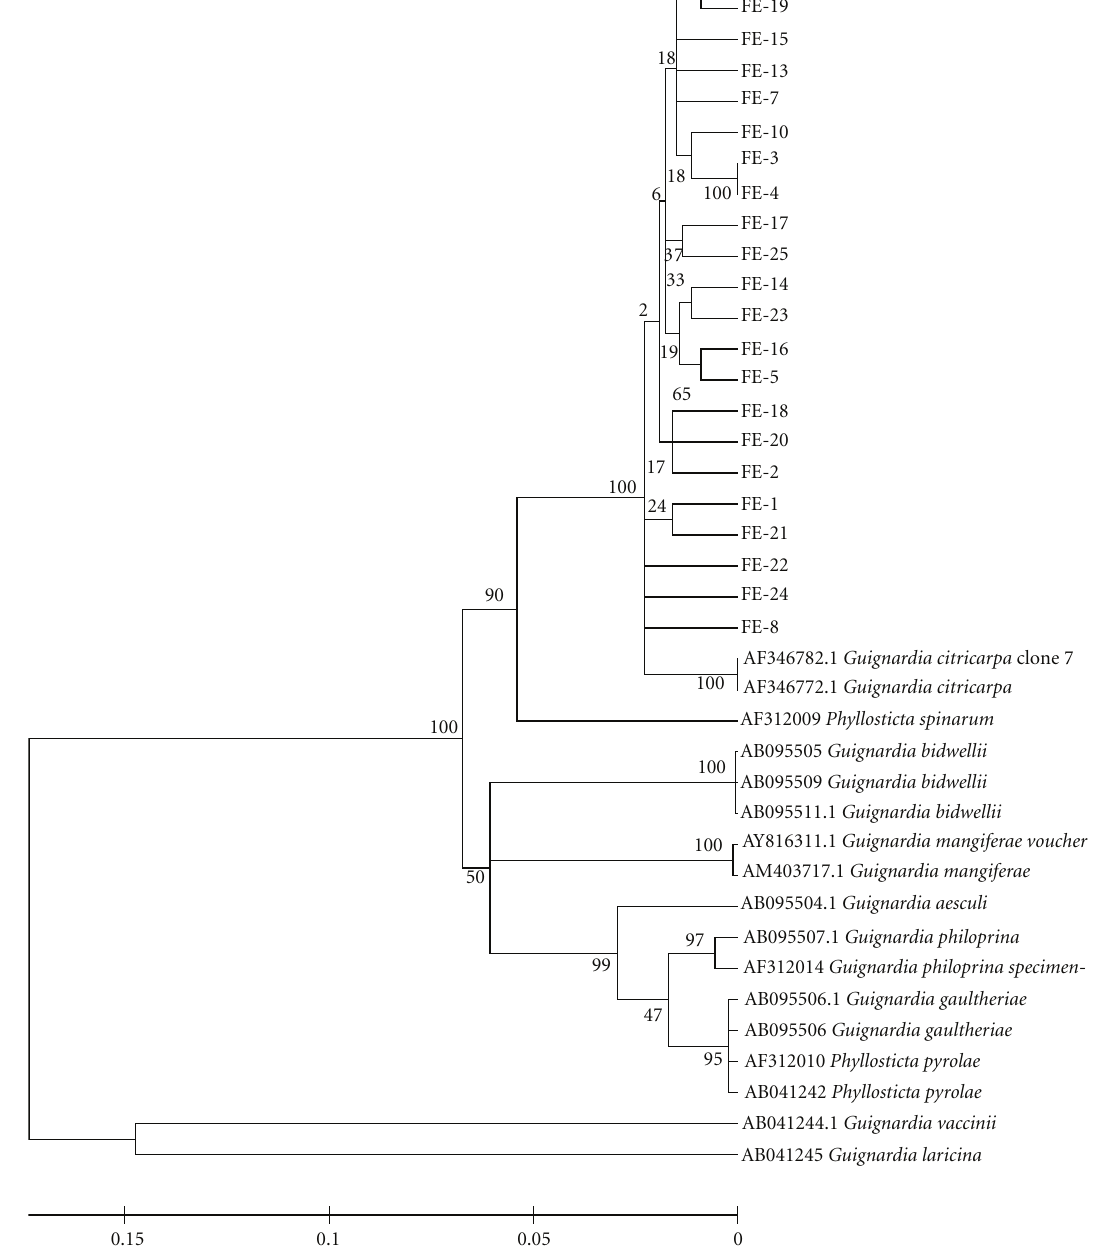
Figure 3: Genetic relationships inferred by ITS1-5.8S-ITS2 DNA sequence from isolates obtained in fruits from di ff erent plants with CBS symptoms of Conchal/SP. It can be verified that all isolates show high similarity to each other and with the G. citricarpa sequence obtained in GenBank. High divergence was found with the obtained isolates and GenBank sequences. The nearest sequence to G. citricarpa belongs to P. spinarum